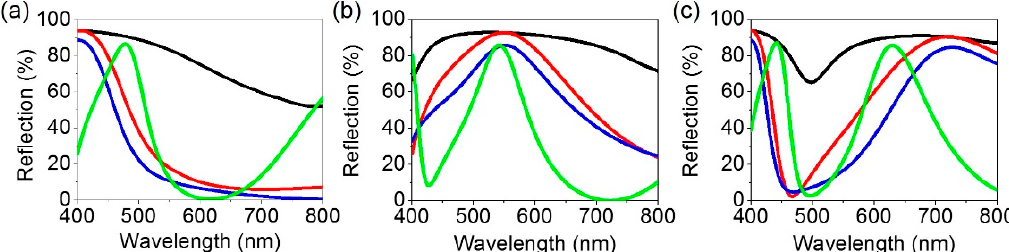
Figure 3. Simulated spectral reflectance curves at normal incidence for ( a ) blue, ( b ) green and ( c ) red colored structures. Black, red, blue and green solid lines represent the reflection spectrum obtained from the structures consisting of TiO 2 (B: 65 nm, G: 100 nm, R: 140 nm) / Al (100 nm), Cr (5 nm) / TiO 2 (B: 65 nm, G: 100 nm, R: 140 nm) / Al (100 nm), SiO 2 (80 nm) / Cr (5 nm) / TiO 2 (B: 65 nm, G: 100 nm, R: 140 nm) / Al (100 nm) and SiO 2 (80 nm) / Cr (5 nm) / TiO 2 (B: 180 nm, G: 210 nm, R: 250 nm) / Al (100 nm), respectively.